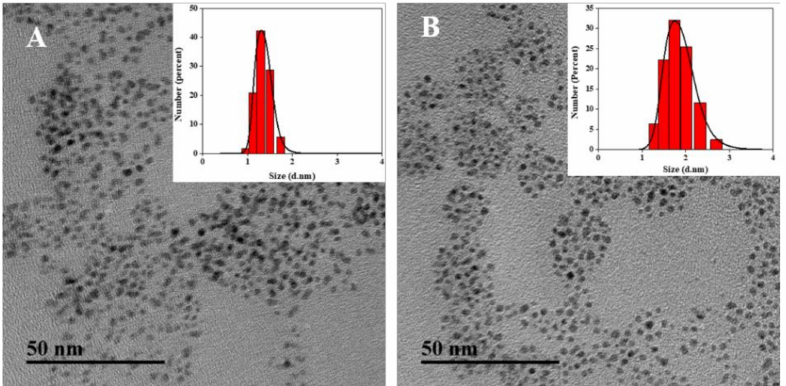
Figure 4. TEM images of GSH/ β -CDs-AuNCs in the ( A ) absence and ( B ) presence of 500 ng/mL paraquat. Inset pictures show the corresponding hydrodynamic diameter of GSH/ β